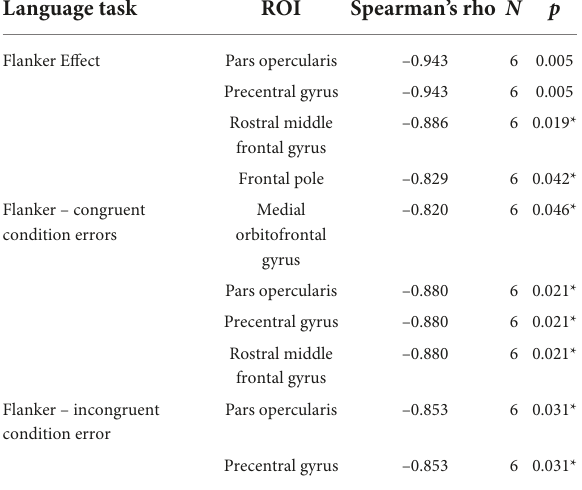
TABLE 9 Significant correlations between cortical thickness in right hemisphere ROIs and pre-therapy cognitive control task outcomes. Language